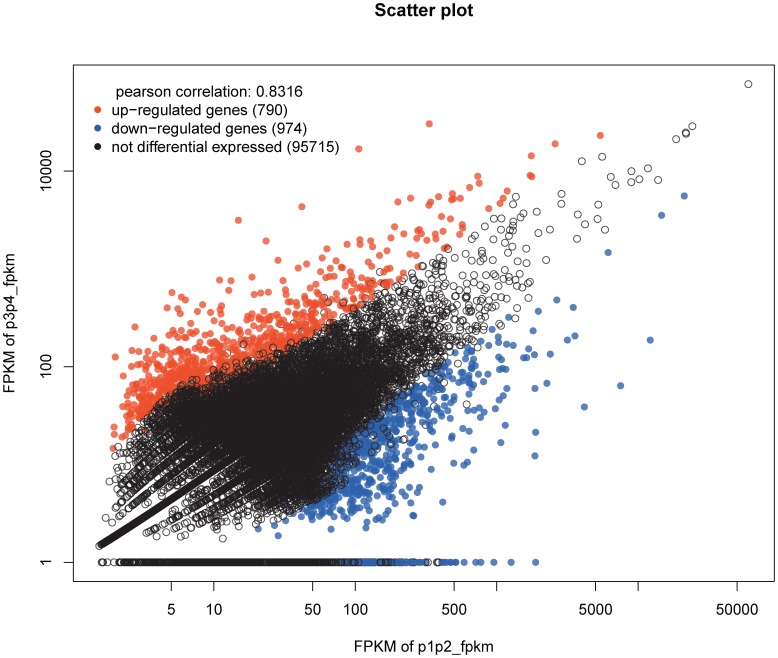
Scatter plot showing the gene expression differences between S1 and S2.The abundance of each gene was normalized as Fragments Per Kilobase of exon model per Million mapped reads (FPKM). The differentially expressed genes are shown in red and blue, while the black indicates genes that were not differentially expressed between S1 and S2.